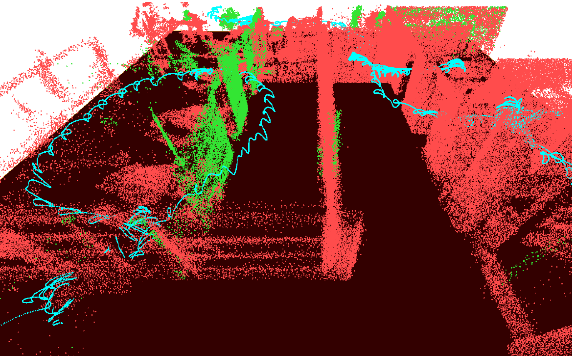
Figure 3. Reflected surfaces are detected and labeled to be removed (green). Trajectory is cyan and correct points are in coral.